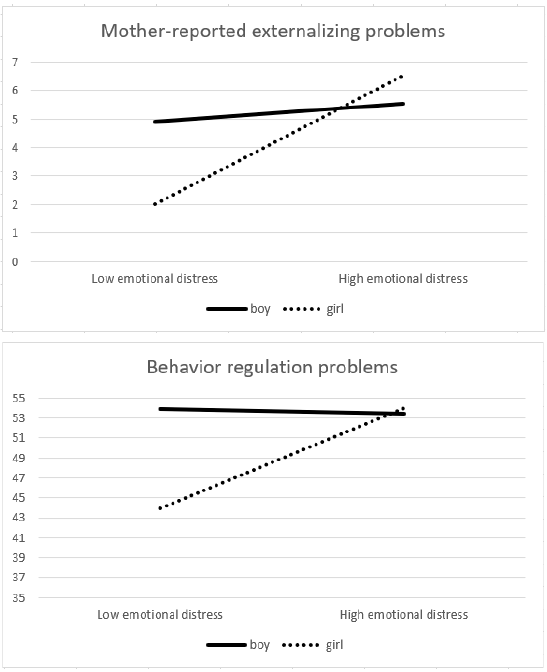
Figure 1. Interaction plots of emotional distress by child gender on child